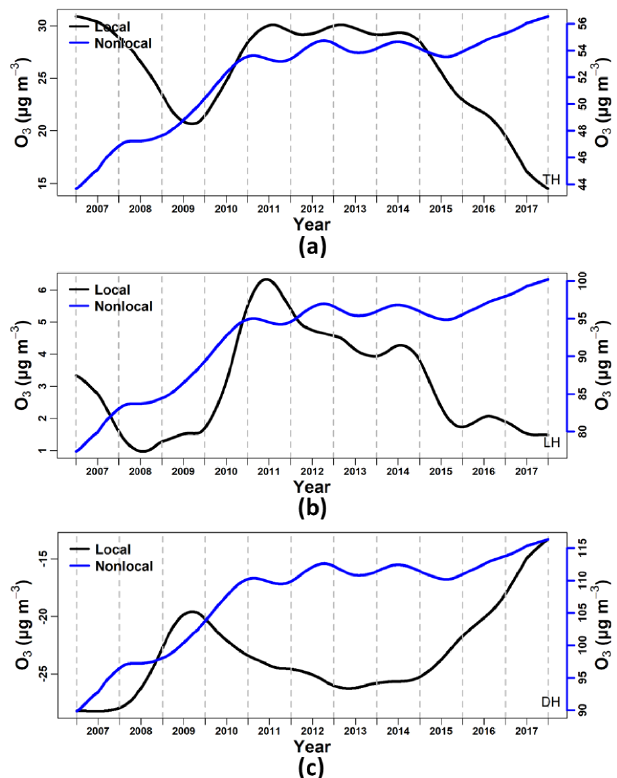
Figure 7. Long-term trend of ozone contributed by local (black) and nonlocal (blue) emission sources from 2007 to 2017 at (a) TH, (b) LH, and (c) DH